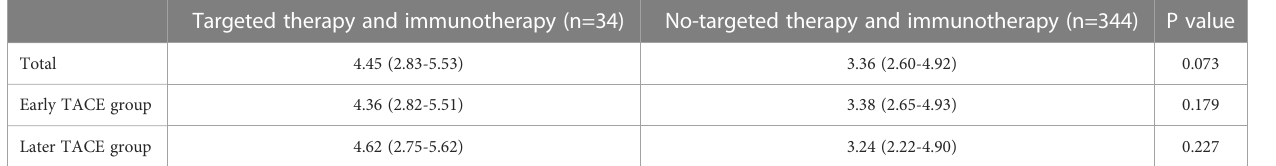
TABLE 5 Effects of targeted therapy and immunotherapy on OS in HCC patients after recurrence. Targeted therapy and immunotherapy